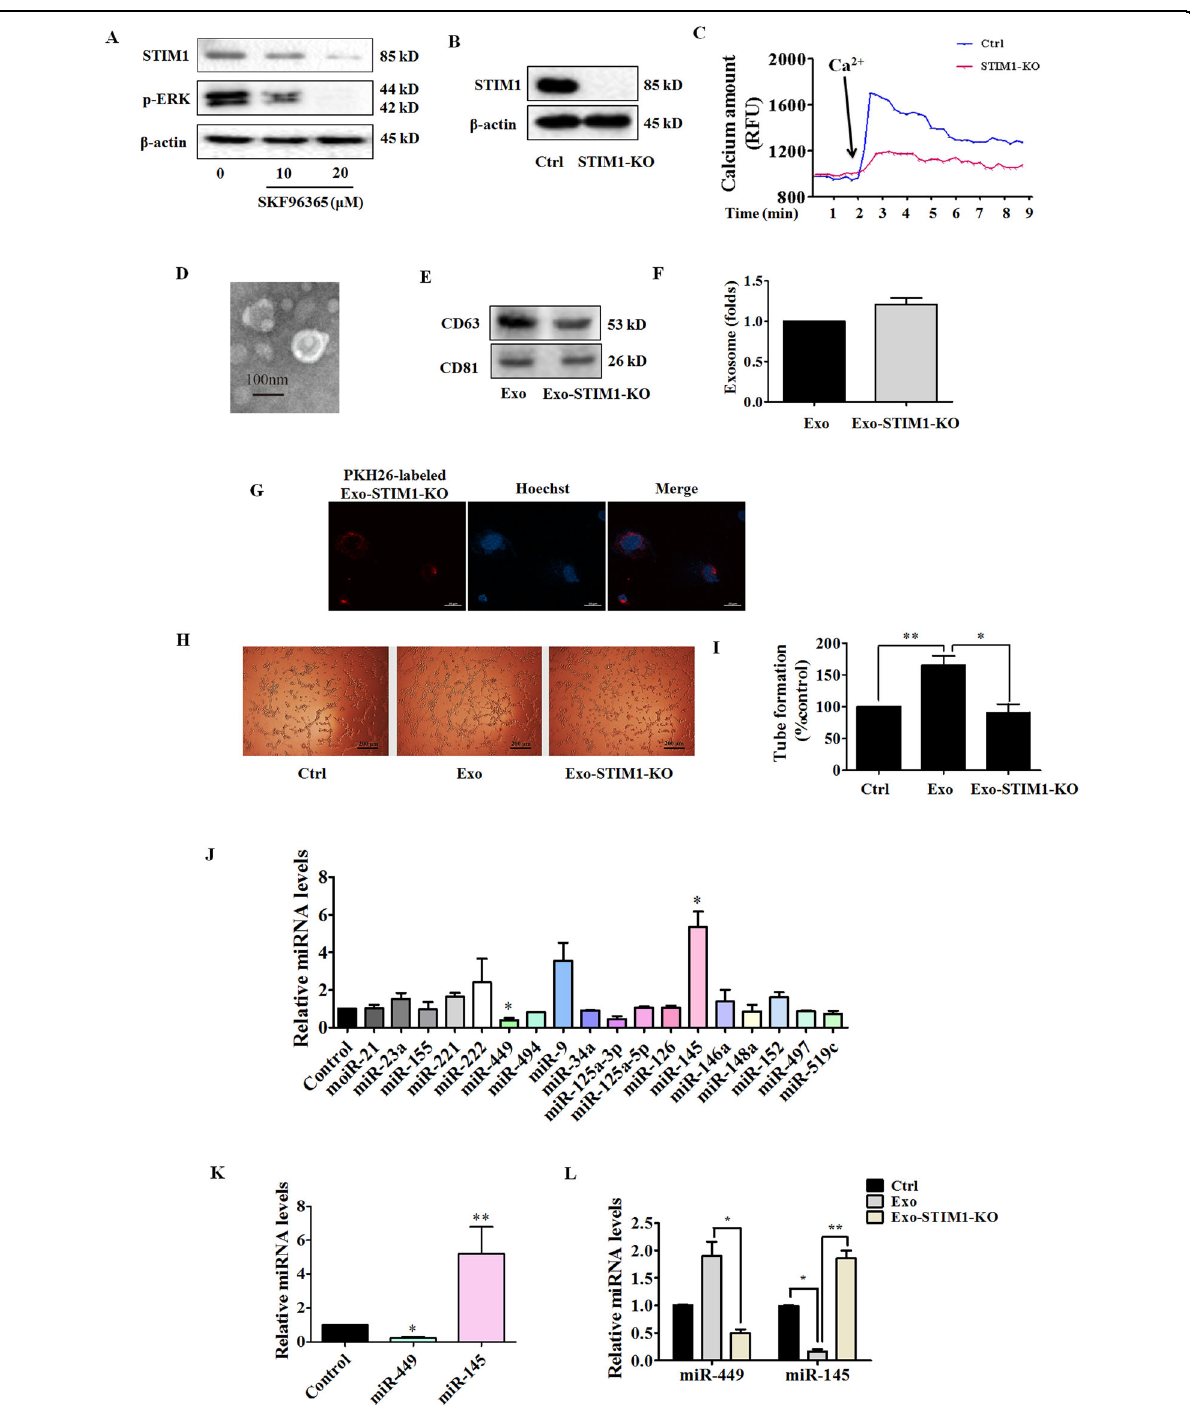
Fig. 4 Exo-STIM1-KO suppresses human umbilical vein endothelial cells (HUVEC) tube formation and increases miR-145 level. A Expression of STIM1 and phosphorylation of ERK in SKF96365-treated MDA-MB-231 cells. B Expression of STIM1 in STIM1-KO MDA-MB-231 cells. C Representative time-course recording of intracellular Ca 2 + fl uorescence in STIM1-KO-MDA-MB-231 cells. D Representative electron microscopic image of Exo-STIM1- KO. E The markers of exosomes in Exo-STIM1-KO, as determined by western blot. F The amount of Exo-STIM1-KO showed no signi fi cant change compared with Exo. G The uptake of Exo-STIM1-KO in HUVECs. HUVECs were cultured with PKH26-labeled Exo-STIM1-KO. H Tube formation was inhibited by Exo- STIM1-KO. I Quanti fi cation of the results in ( H ). J Relative levels of miRNAs in STIM1-silencing MDA-MB-231 cells. K The levels of miR- 145 and miR-449 in Exo-STIM1-KO. L The levels of miR-145 and miR-449 in HUVECs after treatment with Exo and Exo-STIM1-KO. Data represent mean ± SEM from three independent experiments ( n = 3). * P < 0.05, ** P < 0.01.